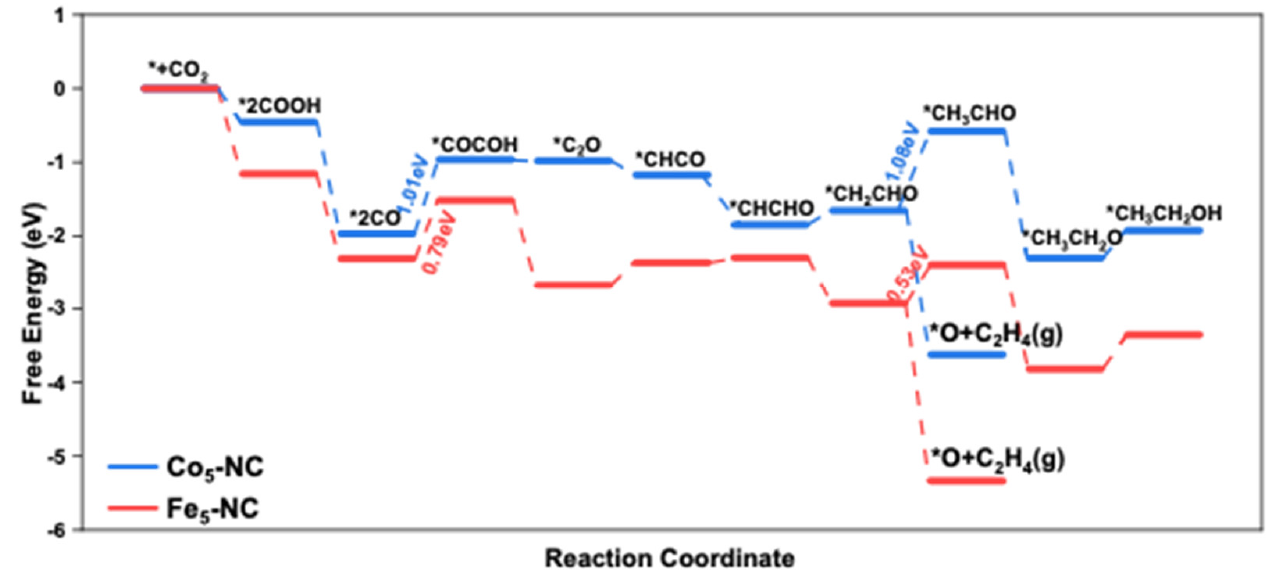
Figure 4. Gibbs free energy profiles for CO 2 RR on Fe 5 -NC and Co 5 -NC.